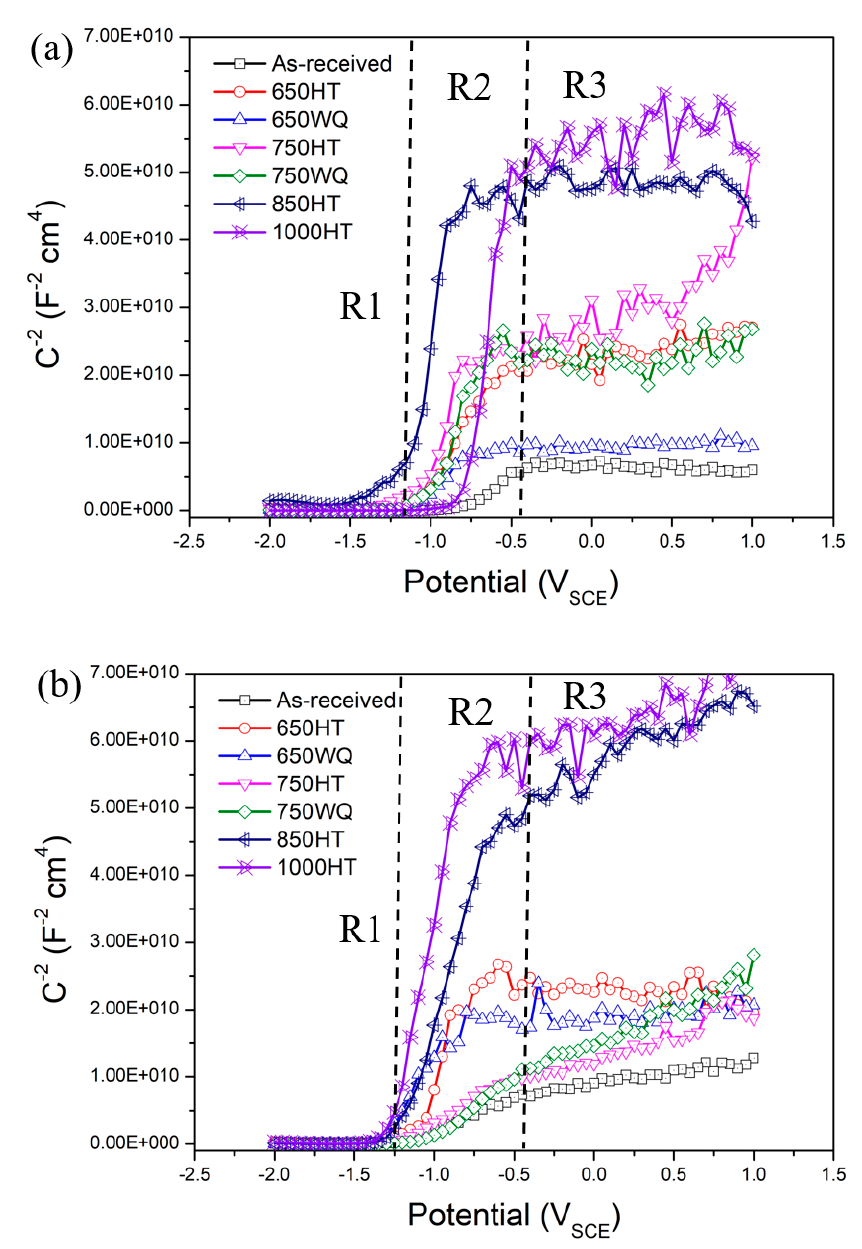
Figure 14. Mott–Schottky plots for the corroded samples after ( a ) E ‐ CLCP and ( b ) E ‐ CLCT for